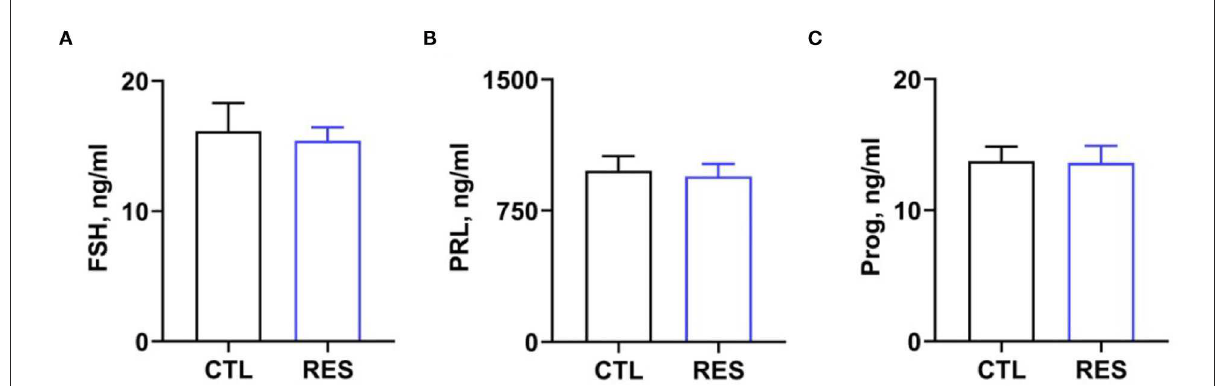
FIGURE3 The effect of resveratrol on serum hormone levels in perinatal sows. (A) Follicle-stimulating hormone (FSH), (B) prolactin, and (C) progesterone. CTL, a basal diet; and RES, a basal diet containing 200 mg/kg resveratrol. Data are expressed as mean ± SD ( n = 10); *, p < 0.05.